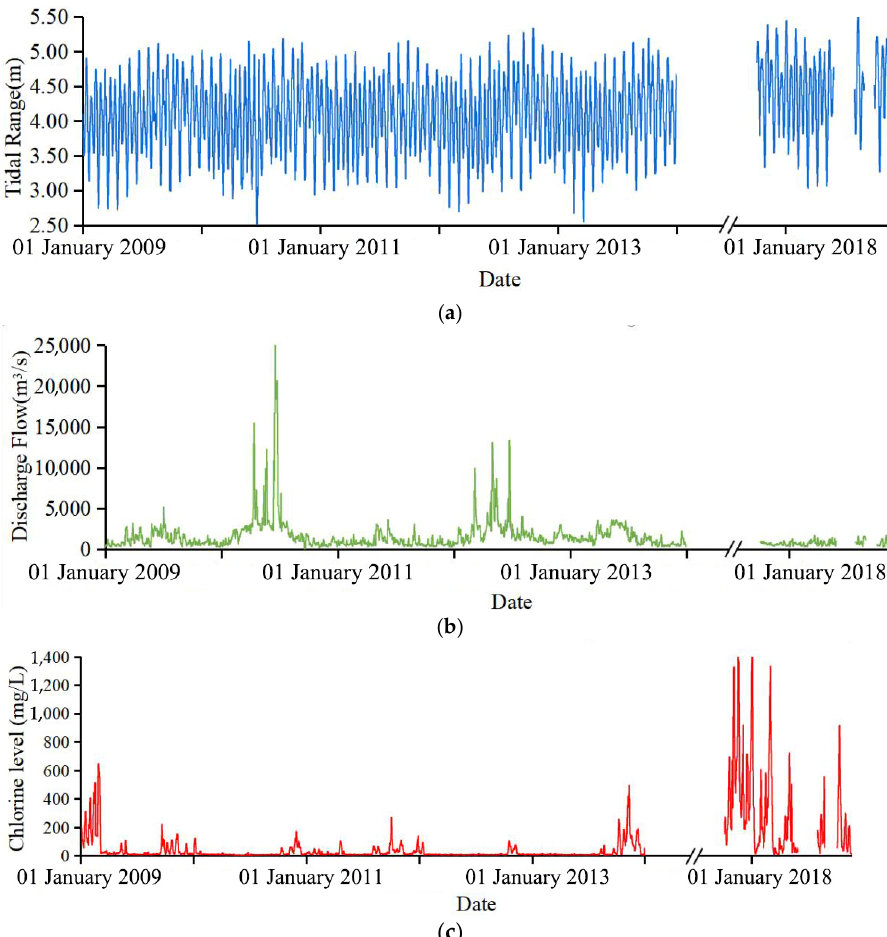
Figure 3. Time series of tide, fl ow, and chlorine level: ( a ) Tidal range; ( b ) Discharge fl ow; ( c ) Chlorine level.